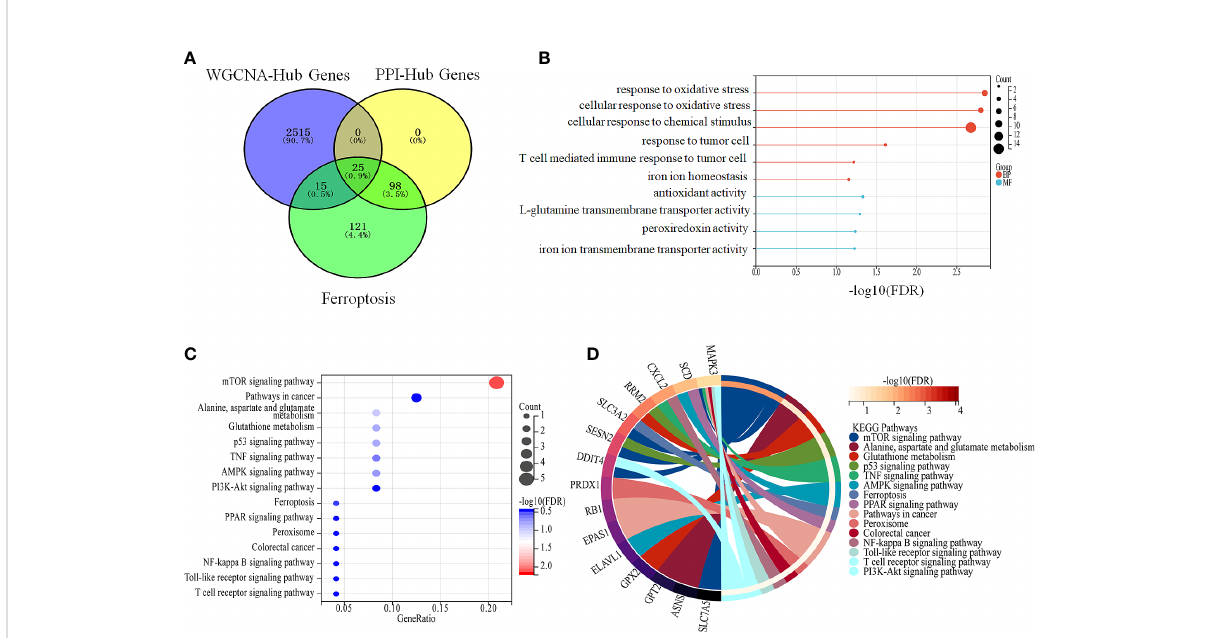
FIGURE 5 Intersecting genes are involved in ferroptosis in colon cancer. (A) Intersection of DEGs that were obtained from PPI, WGCNA analysis and ferroptosis genes (B, C) Enrichment analysis of intersecting genes. (B) Enrichment analysis of intersecting genes with biological processes related to ferroptosis. (C) Enrichment analysis of crossed genes with ferroptosis-related pathways. (D) Speci fi c intercalating genes in ferroptosis- related pathways.